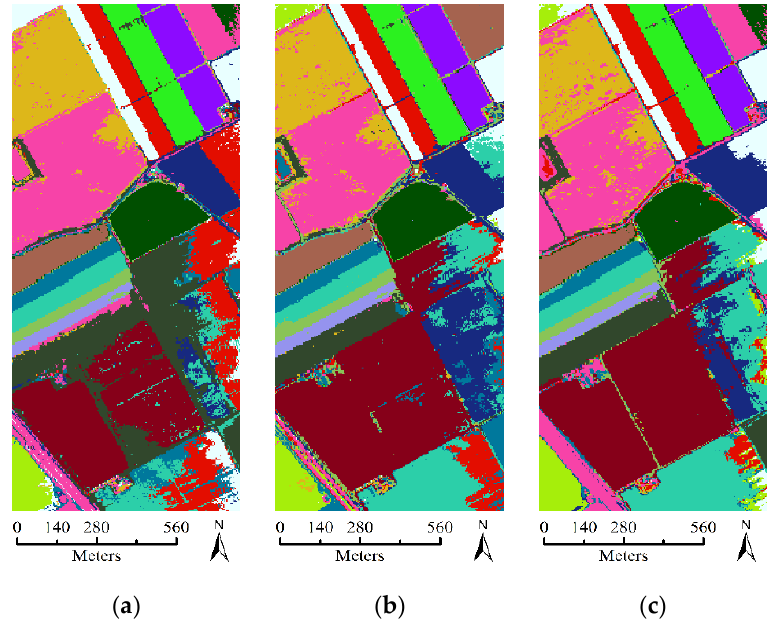
Figure 11. Classification maps of Salinas Valley dataset obtained by using different spatial neighborhood information: ( a ) SA (96.06%); ( b ) SP (94.91%); ( c ) FS (94.48%).